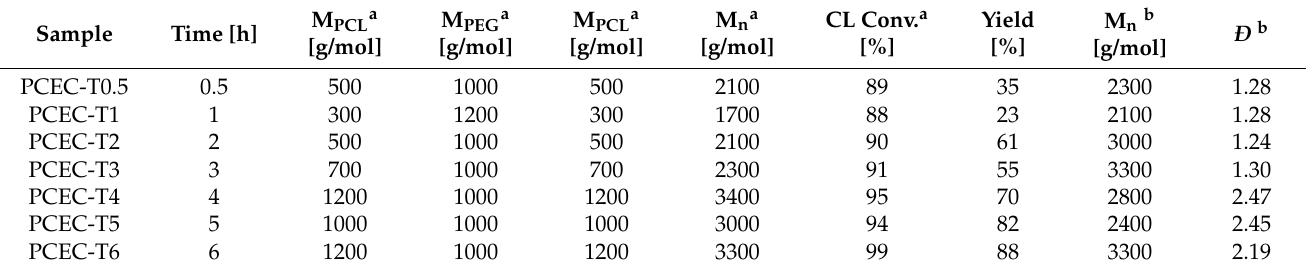
Table 3. The ROP kinetics over a time period of 0.5–6 h.